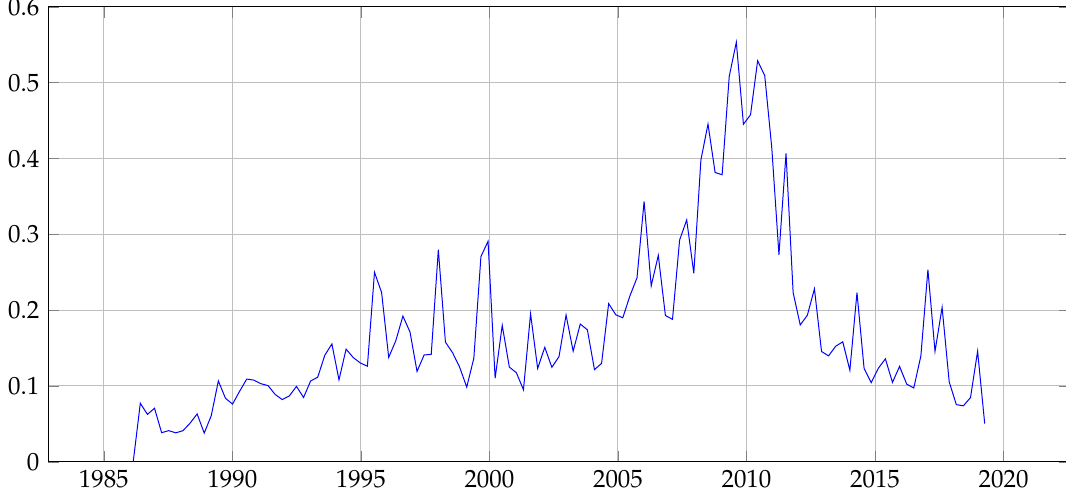
Figure 2. Time series of average values of the density of earthquake epicenters throughout the analysis area (trend